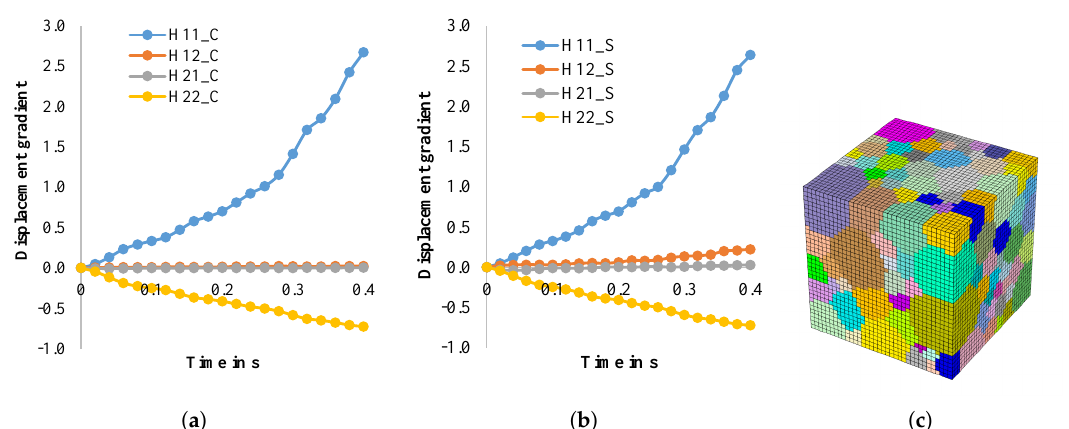
Figure 6. Displacement gradient in cold rolling of Fe3.2wt.%Si with a homogenous microstructure, ( a ) in the mid-layer and ( b ) near the surface. ( c ) Corresponding RVE with 300 grains used in both cases. 11—displacement gradient in normal direction, 22—displacement gradient in rolling direction, 12 and 21—displacement gradient indicating shear, C—mid-layer, S—near surface layer near the surface for initial homogeneous hot strip microstructure: